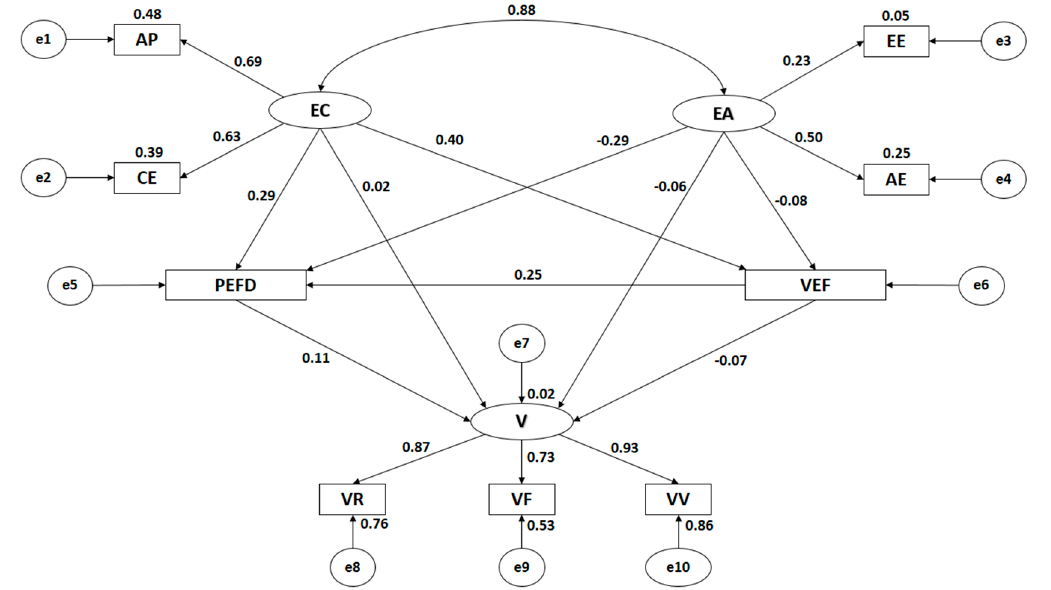
Figure 3. Structural equation model for sedentary